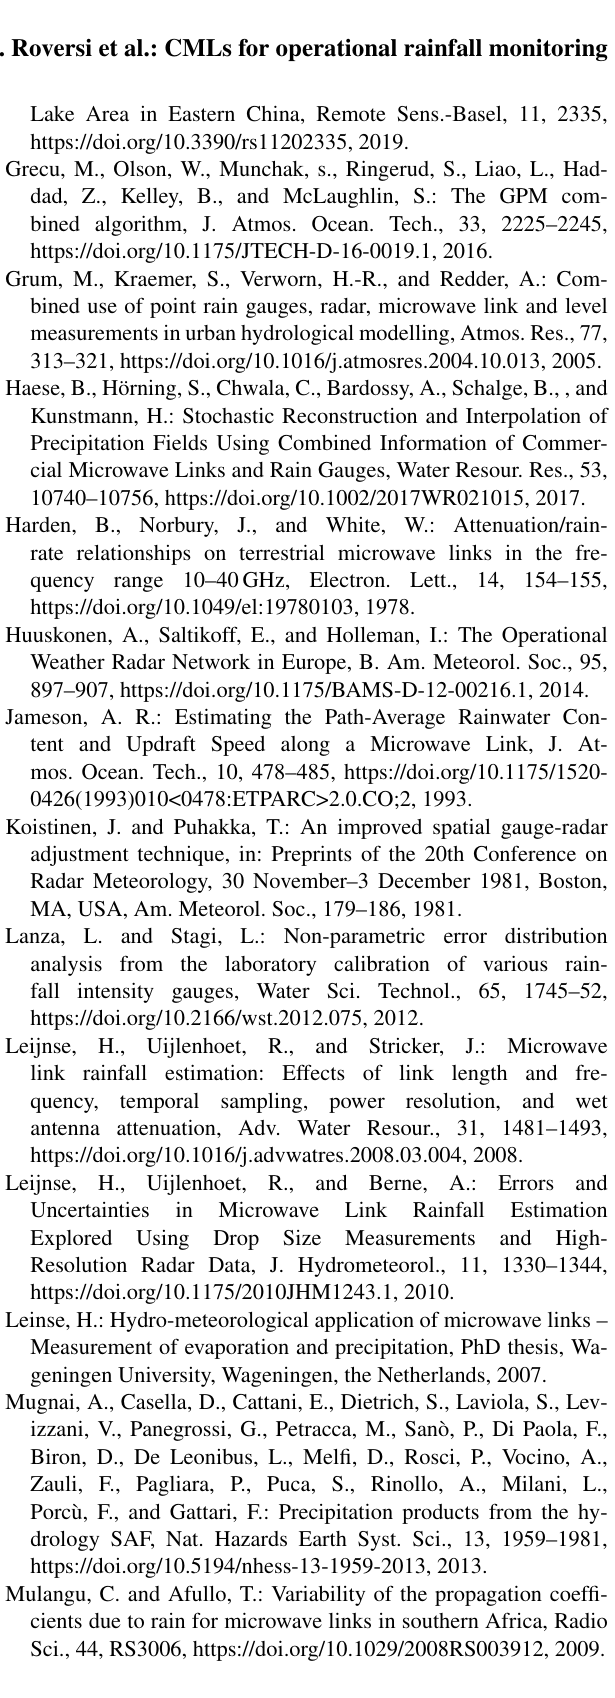
Tabary, P.: Long-term monitoring of French polarimetric